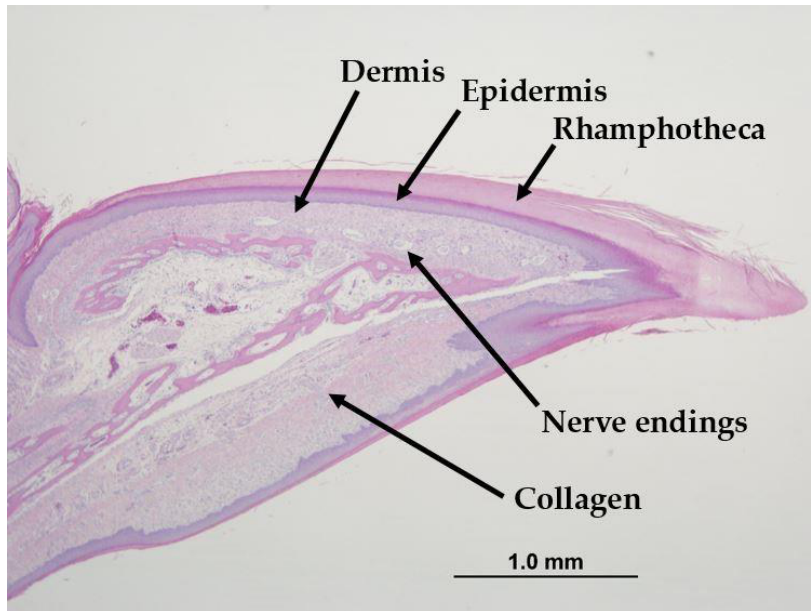
Figure 4. Histological section of the top beak of a C pullet. The three tissue layers of the beak (rhamphotheca, epidermis, and dermis) are indicated. Multiple nerve endings (Herbst corpuscles) and mature collagen bundles are visible within the dermis layer. H&E staining. Magnification 4×.